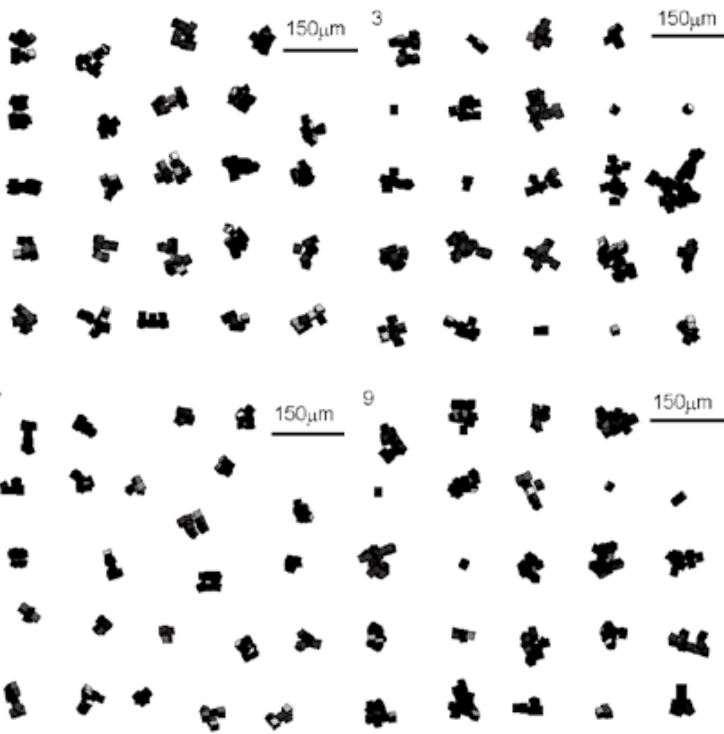
Fig. 6 Selected, representative particle morphologies for the cases 1, 3, 7 and 9. The aggregates were sampled randomly from the active set.